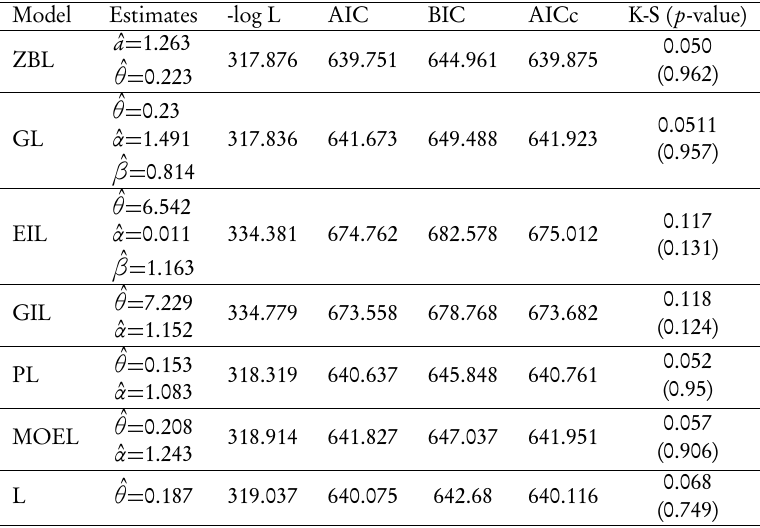
Estimates and statistics for the data of waiting times of 100 customers.